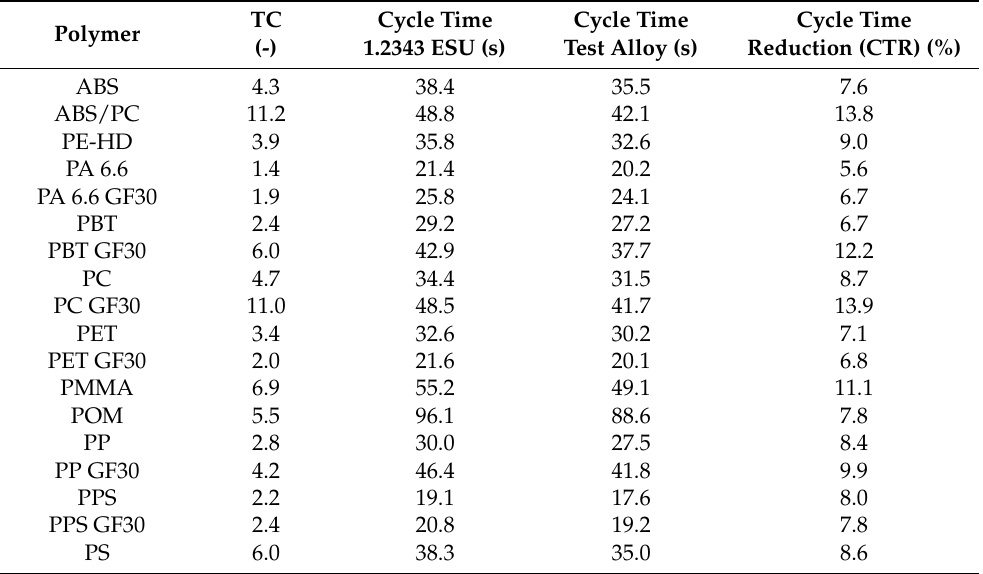
Table A2. Temperature coefficient (TC), cycle times, and cycle time reduction (CTR) for the investi- gated polymers for 3 mm part